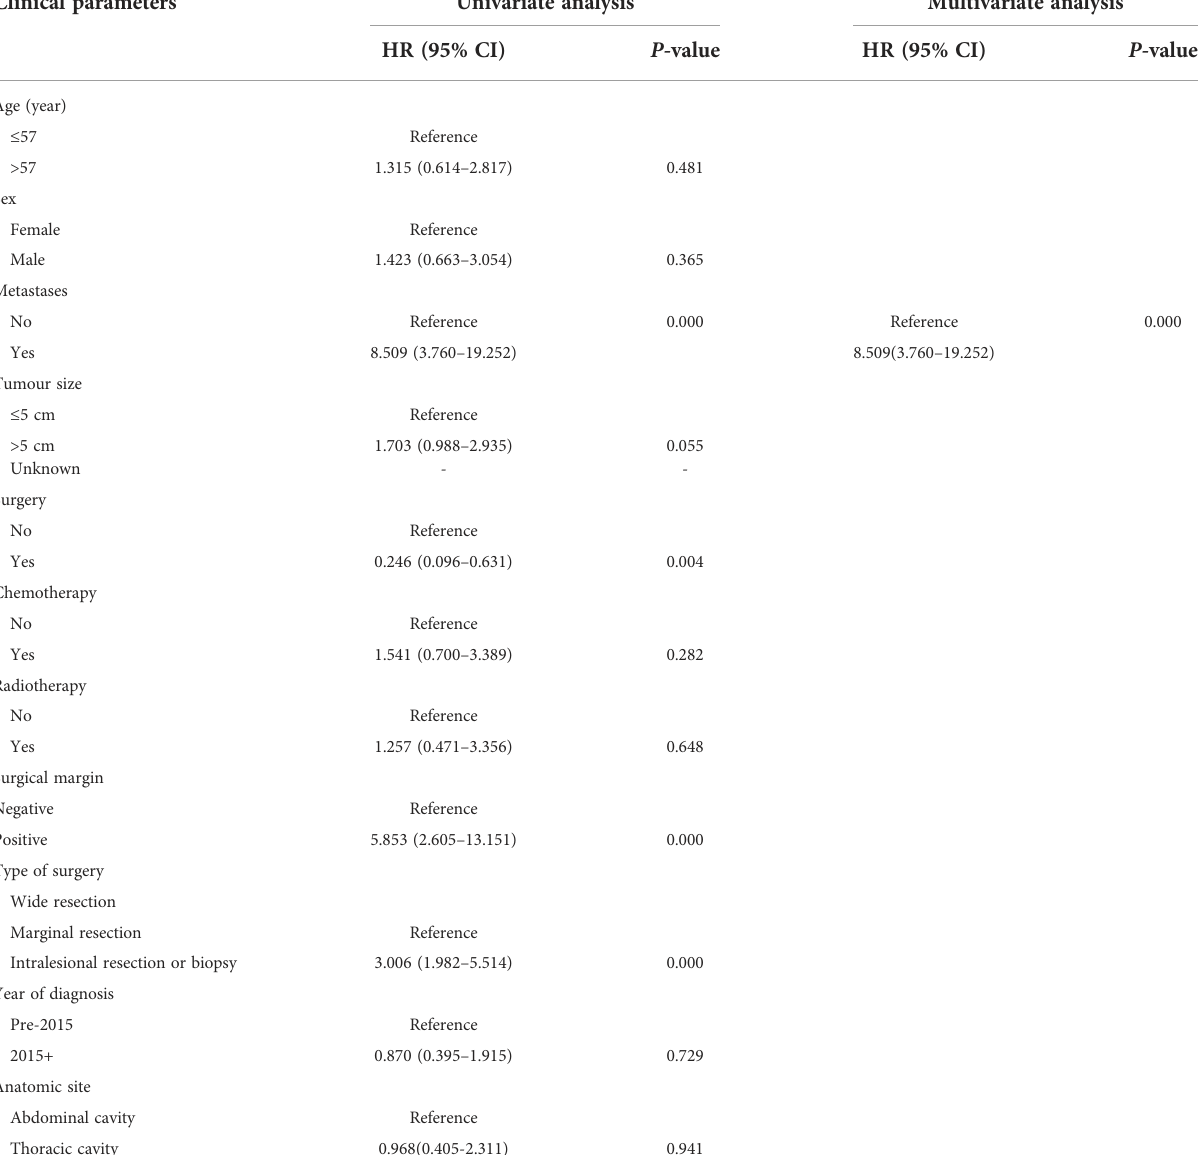
TABLE 4 Univariable and multivariable analyses of the EFS in patients with visceral sarcomas. Clinical